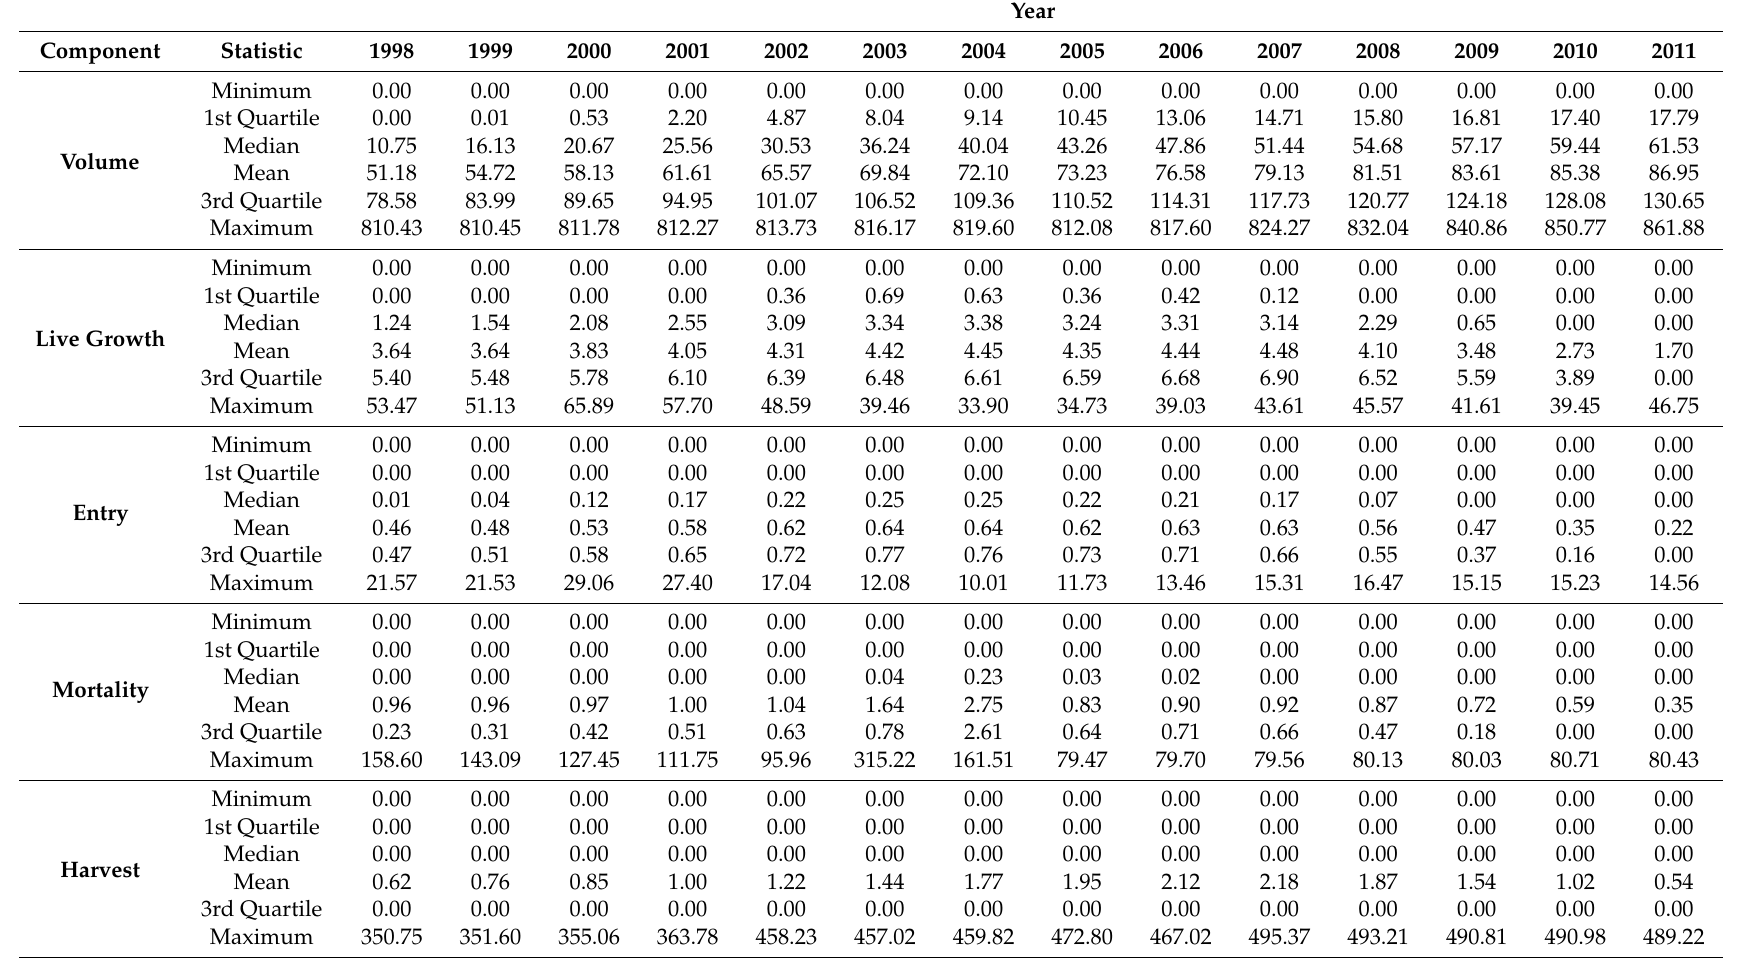
Table A3. Distribution statistics for population